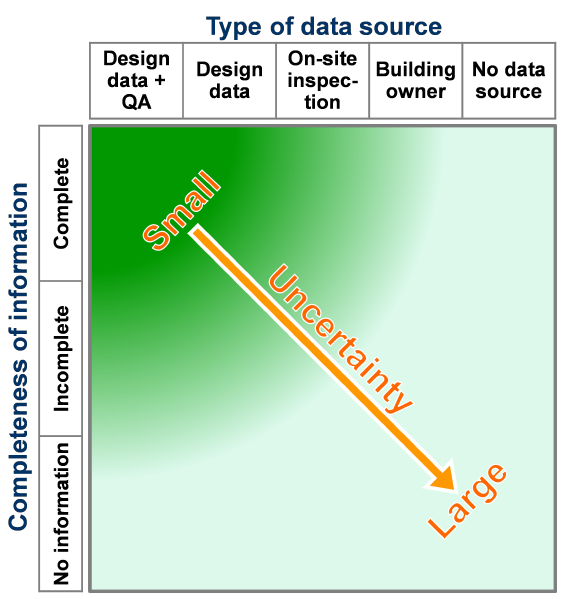
Figure 2. Influences on the uncertainty of an energy performance